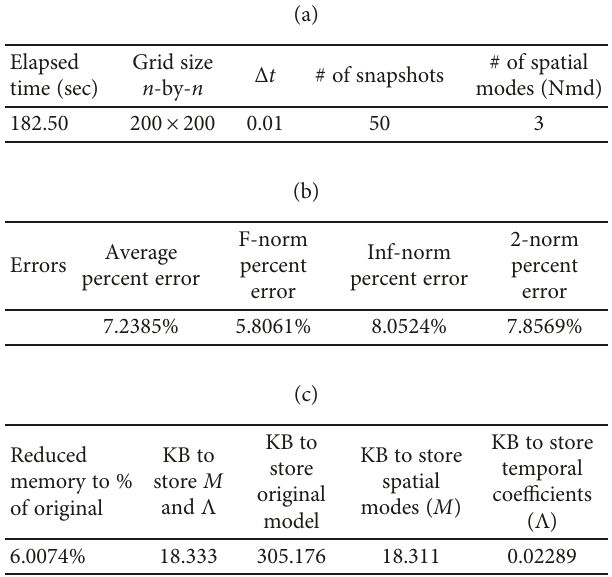
Algorithm 2 Fitted quadratic polynomial Figure 4: Average percent error vs. Δ t . Table 6: Algorithm 2 results (200 × 200 grid, 50 snapshots per submatrix, and 3 spatial modes per